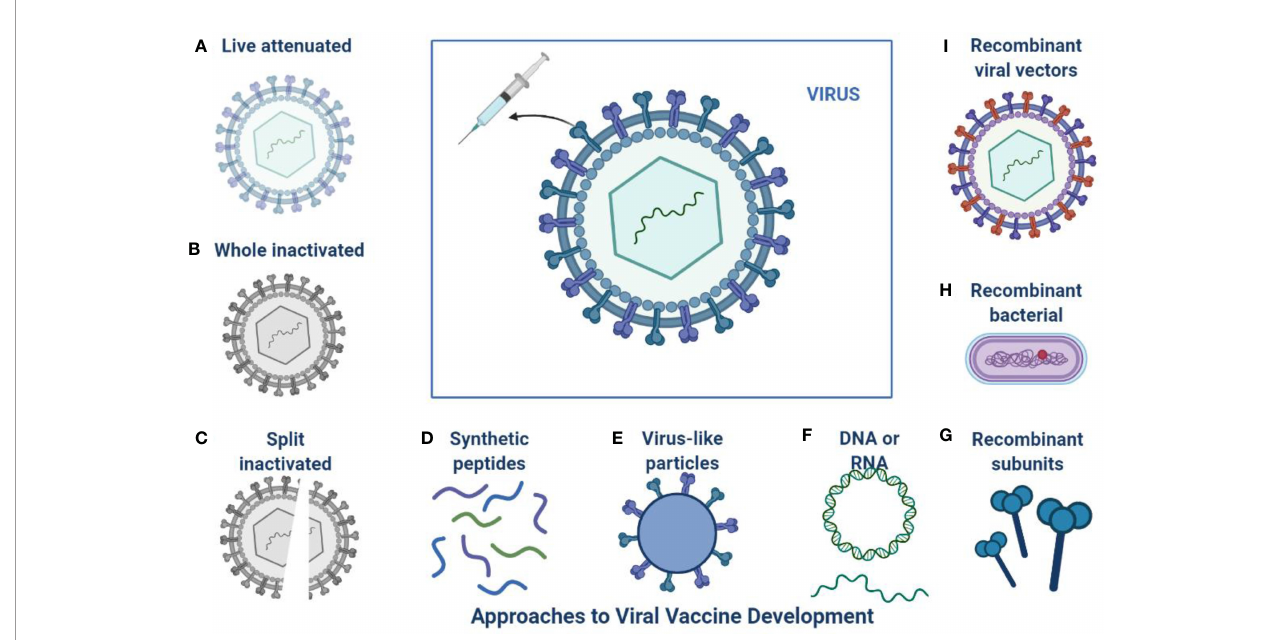
FIGURE 2 | Approaches to SARS-CoV-2 Vaccine development: This is an overview of different platforms for viral vaccine development including (A) Live attenuated (B) Whole inactivated (C) Split inactivated (D) Use of synthetic peptides (E) Virus like particles (F) DNA or RNA (I) Recombinant viral vectors (H) Recombinant bacterial (G) Recombinant subunits.